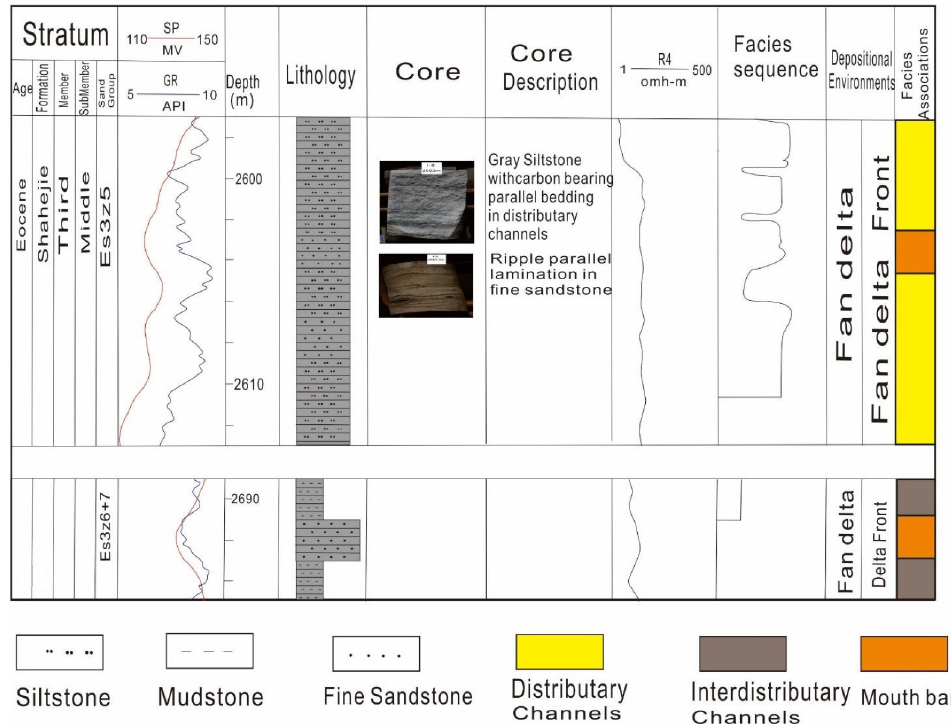
Figure 8. Core well l-8 in study area, showing the trend of logs suits with lithology, core and sedi- mentary facies. Medium to coarse sandstones, conglomeratic and massive sandstones have a boxed shape on GR log with lower to medium amplitude values, trending from coarsening to the fining upward. Parallel bedding, and cross bedding are found in these deposits (Fig- ures 4 and 5). Conglomerates are associated both with mudstones and sandstones in the study area, representing a high energy environment and are found in channel deposits. Sometimes these deposits exhibit scour surfaces that indicate the erosion of sediments on the basal side, and it is not associated with any lithology. These are found both in mud- stone and sandstones of the Es3z and occur when coarse grained sediments overlay the scour surfaces (Figures 4 and 5). Box shape trends of distributary channels are shown in (Figure 6), which display lower GR values, and are interpreted to have inversely graded conglomeratic sandstone (CSg) with intercalated angular gravels (mud clasts) at the depth of 2628.25 m in well Y22. Basal contact of (CSg) has gradational contact with sandy con- glomerates (Figure 6) that turns into interbedded mud and sand at the bottom (Figure 6). As we move towards the basin side, synsedimentary faults (SSM) are found at the depth of 2634.35 m in well Y22, particularly in those lithologies in which muds and sands have alternate parallel layers, and are interpreted as sheet sand deposits due to the correspond- ing log showing a serrated shape (Figure 6). These micro normal faults appear on deltaic slopes and are suggested to occur as a result of the normal growth faults, which cause sliding in weak lithologies.